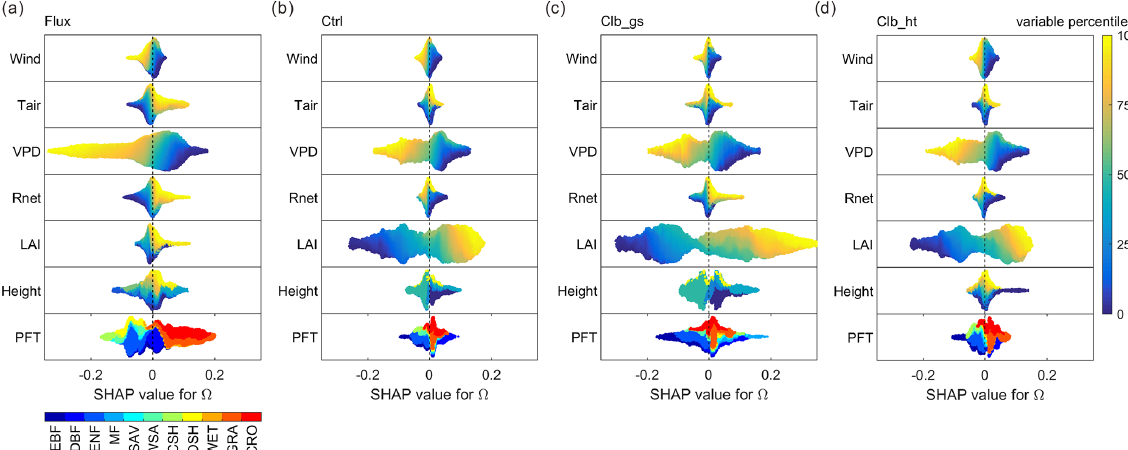
Figure 5. Beeswarm plots showing the dependence of (cid:127) SHAP values to different factors. For each data point, the percentile of the factor’s value in all samples is shown in color. The SHAP value, or contribution of this factor value to deviate the daytime (cid:127) from the average (cid:127) of all samples, is shown in the x axis. In each subplot, data points at a certain SHAP value level are sorted by the factor percentile (i.e., vertical gradient indicates the distribution of factor values in the data). (a) Based on the observation dataset, (b) , (c) and (d) are for Ctrl , Clb_gs and Clb_ht simulations, respectively.